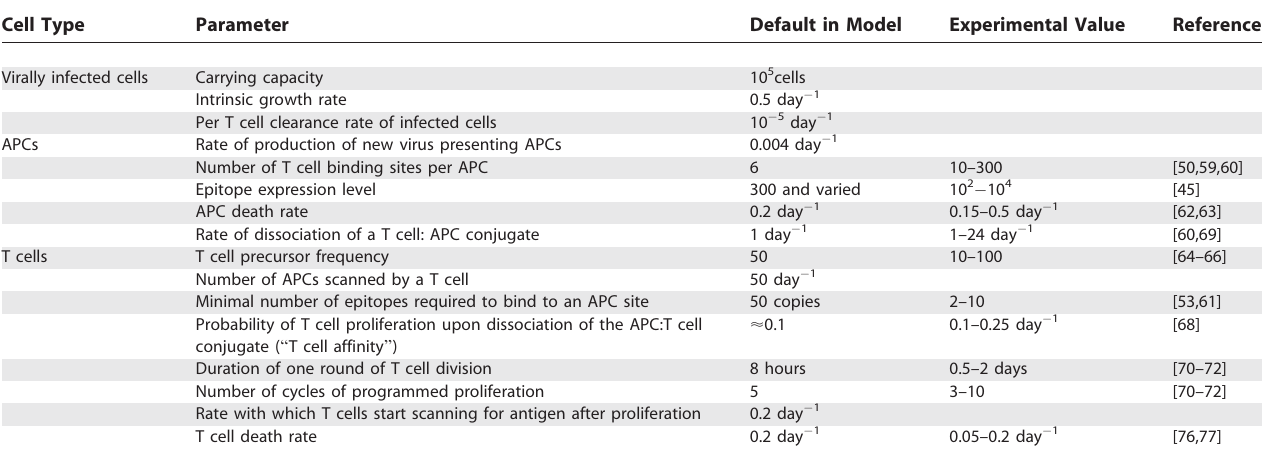
Table 1. Parameter Values of the Model and Experimental